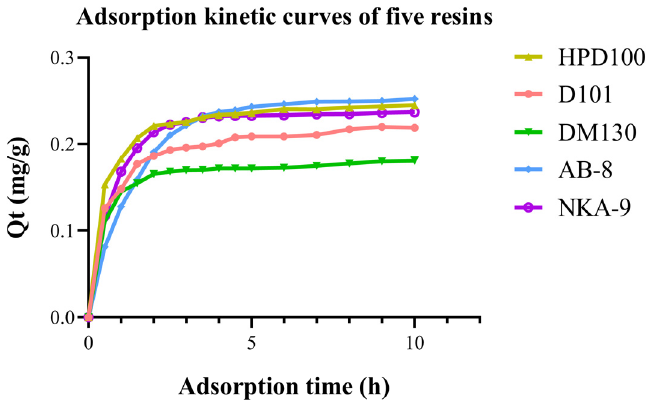
Horticulturae 2023 , 9 , 166 Figure 3. Adsorption kinetic curve of OCS from extraction of C. nitidissima Leaves with 5 resins.